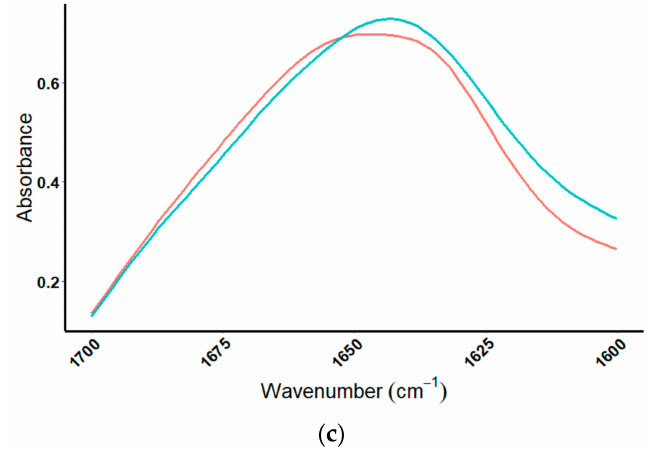
Figure 8. Amide I region comparing ISO100 protein powder to known mixtures of protein standards. ( a ) MIR spectrum comparing ISO100 protein powder to a (1:1) mixture of α -lactalbumin: β -lactoglobulin. ( b ) MIR spectrum comparing ISO100 protein powder to a (1:1:1) mixture of α -lactalbumin: β -lactoglobulin:BSA. ( c ) MIR spectrum comparing ISO100 protein powder to a (1:1:1:1) mixture of α -lactalbumin: β -lactoglobulin:BSA:IgG. In all cases, = ISO100 protein powder and = mixture of